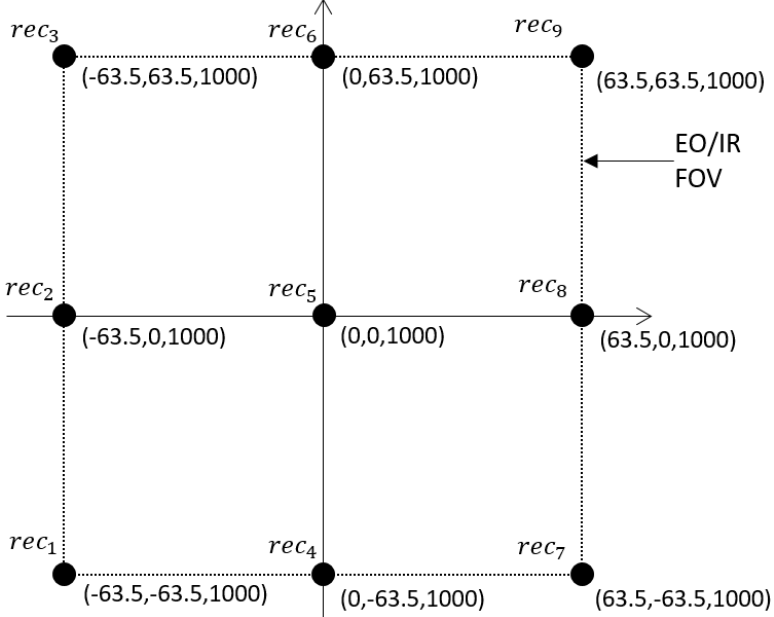
Figure 2. Coordinates of the multi-spectral and RF sensors in reference to the plane in which the moving vehicles